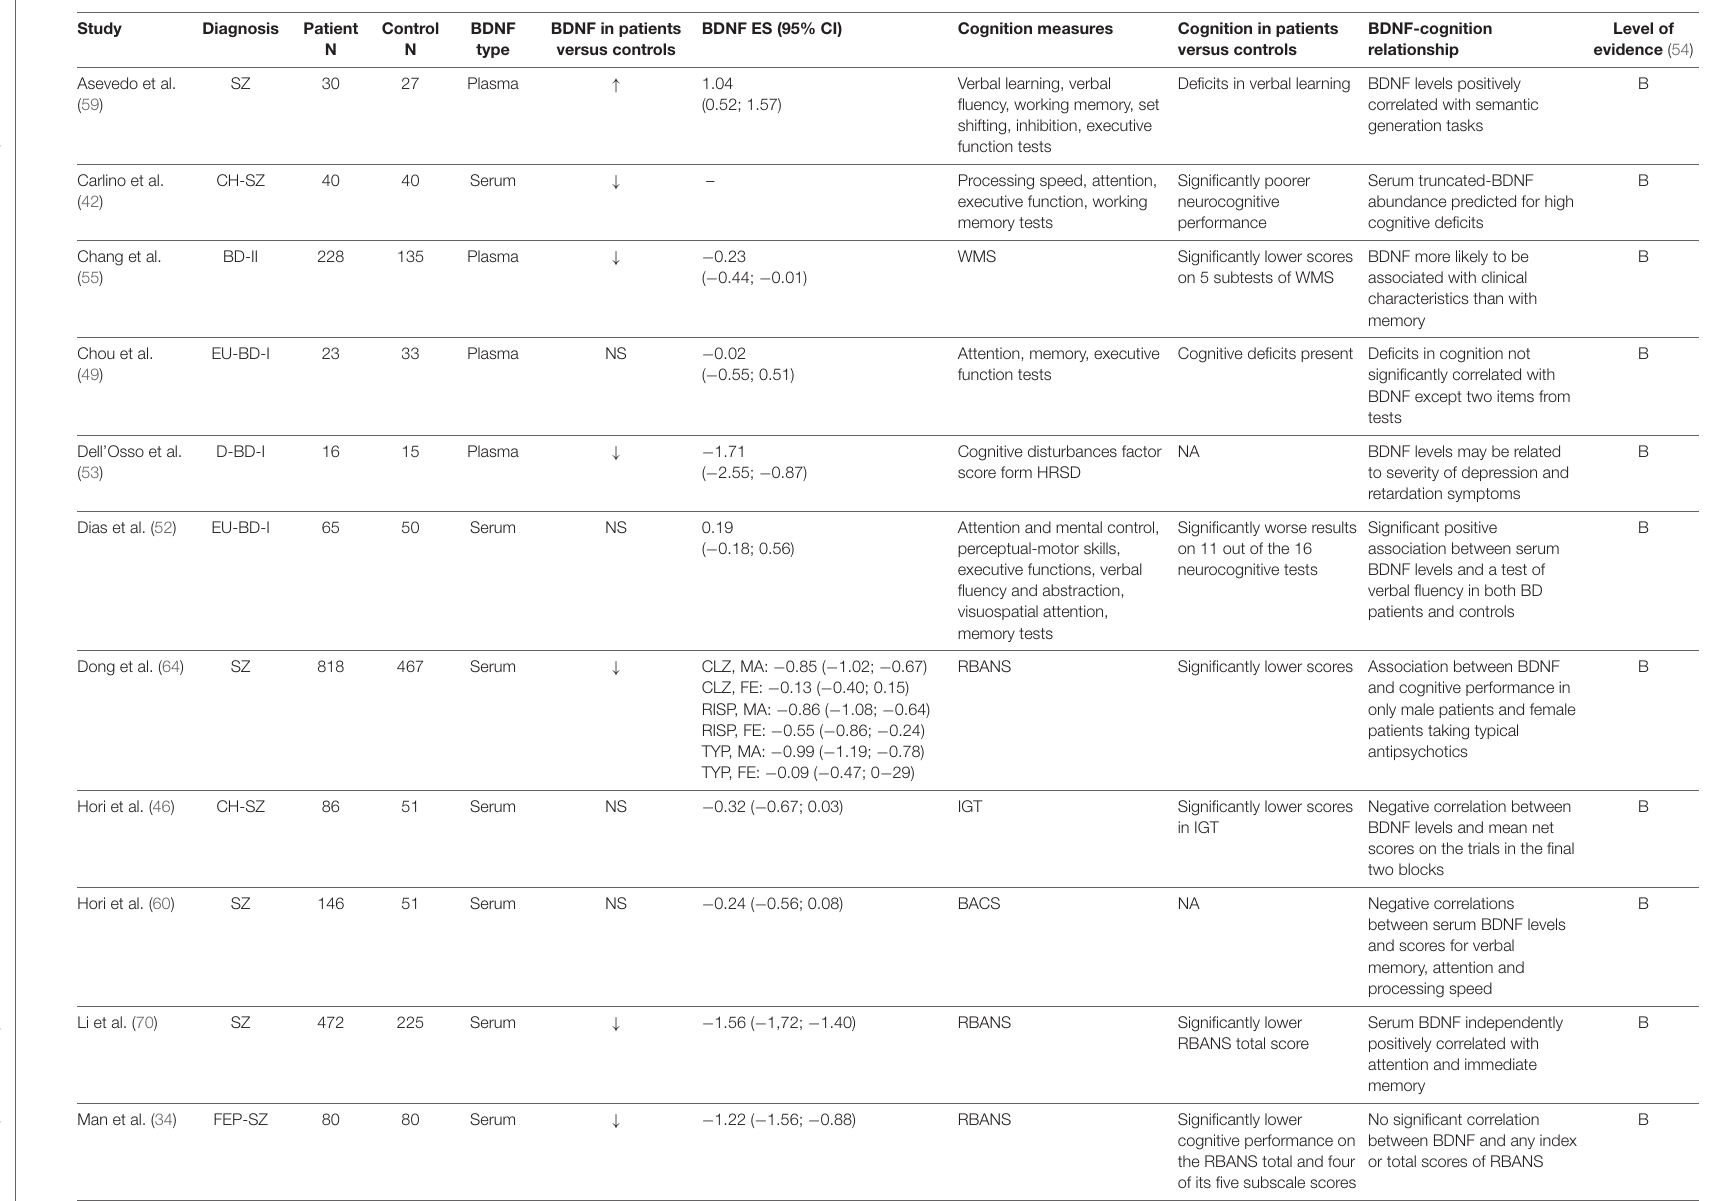
TABLE 1 | Summary of